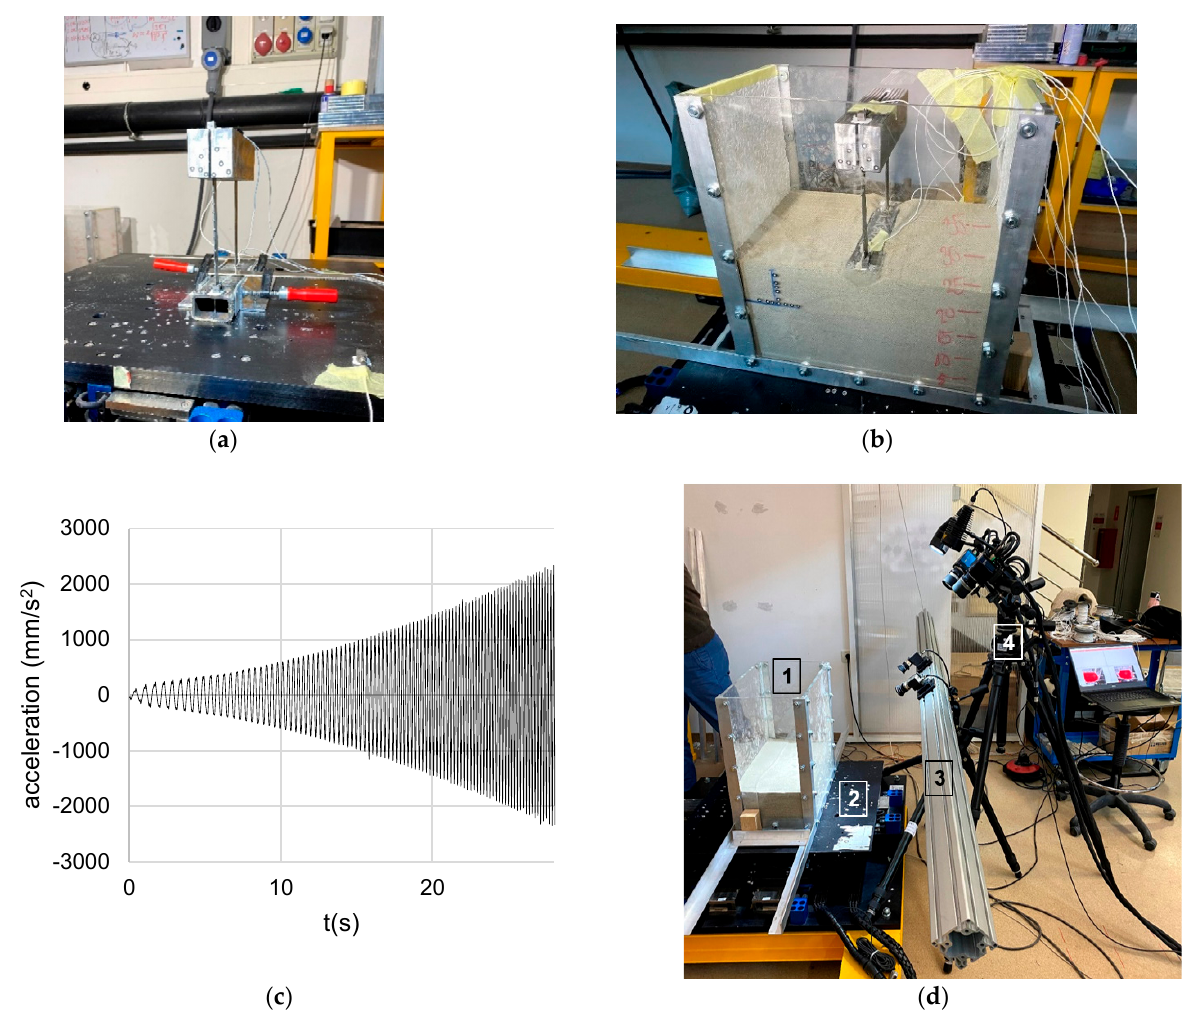
Figure 2. Physical model tested as fixed at the base ( a ), and founded on the sand bed ( b ), excitation function ( c ) and testing setup ( d ).